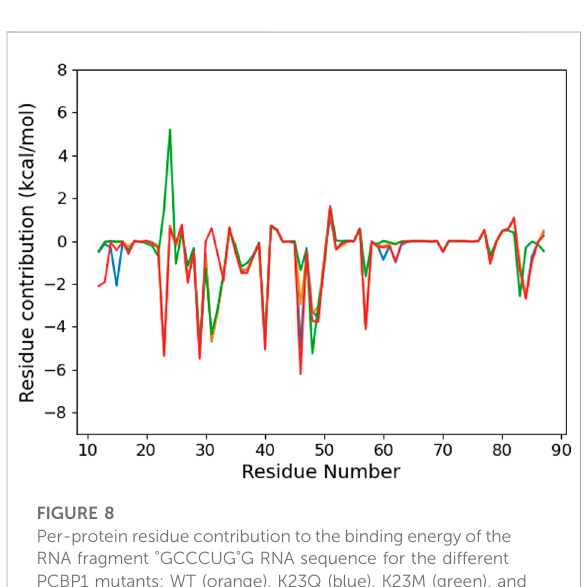
FIGURE 8 Per-protein residue contribution to the binding energy of the RNA fragment ° GCCCUG ° G RNA sequence for the different PCBP1 mutants: WT (orange), K23Q (blue), K23M (green), and K31D (red).